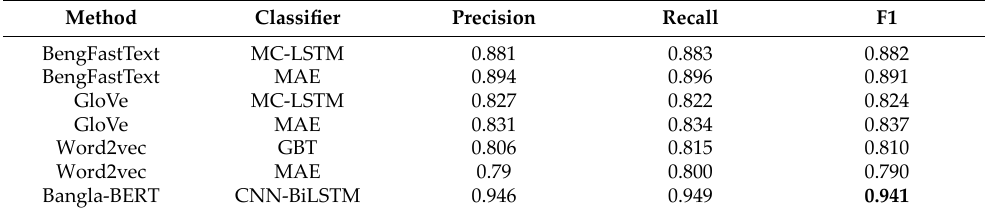
Table 7. Performance of hate speech